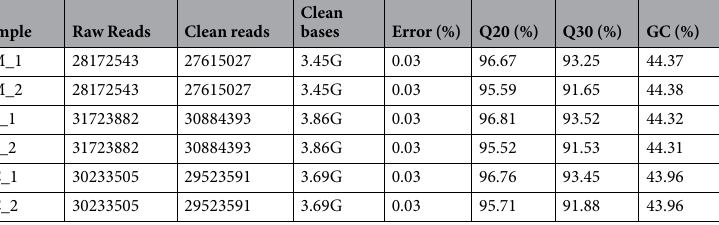
Table 1. Summary of de novo sequence assembly for A . hypogaea root treated with either M . anisopliae (AM), F . axysporum (AF) or untreated control (AC).